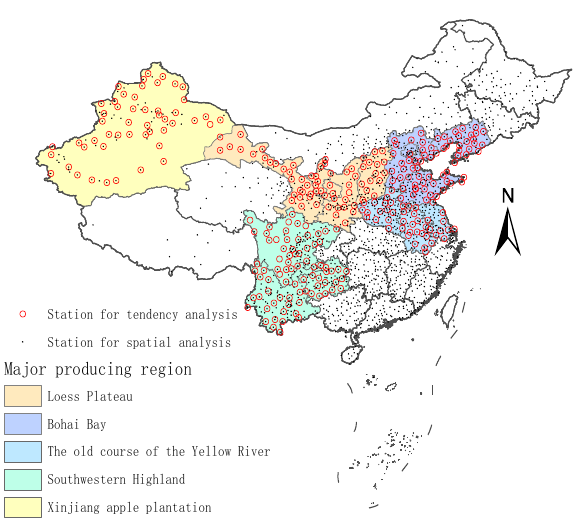
Figure 1. Research areas and the distributions of weather stations and apple plantations in China.